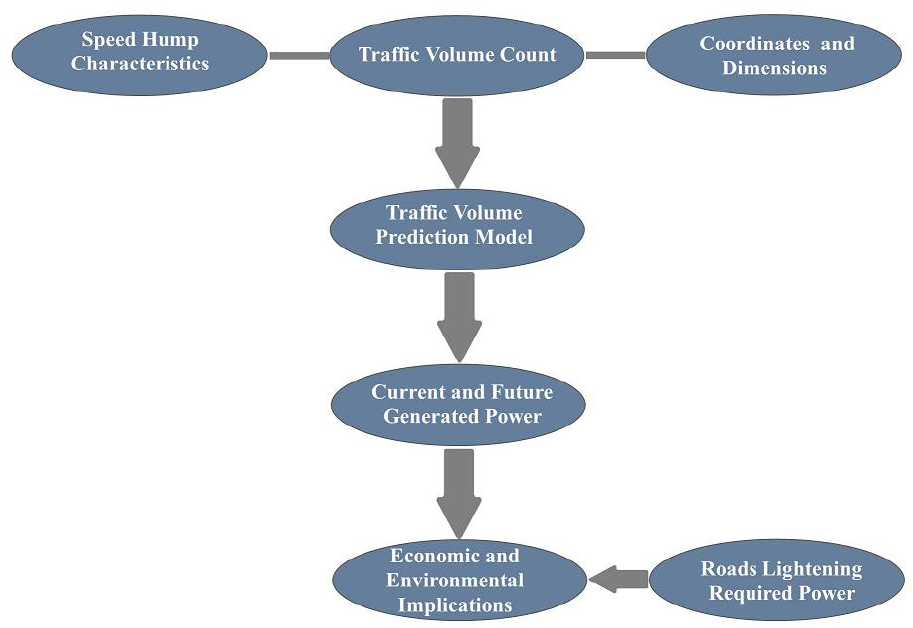
Figure 1. Implemented Methodology .